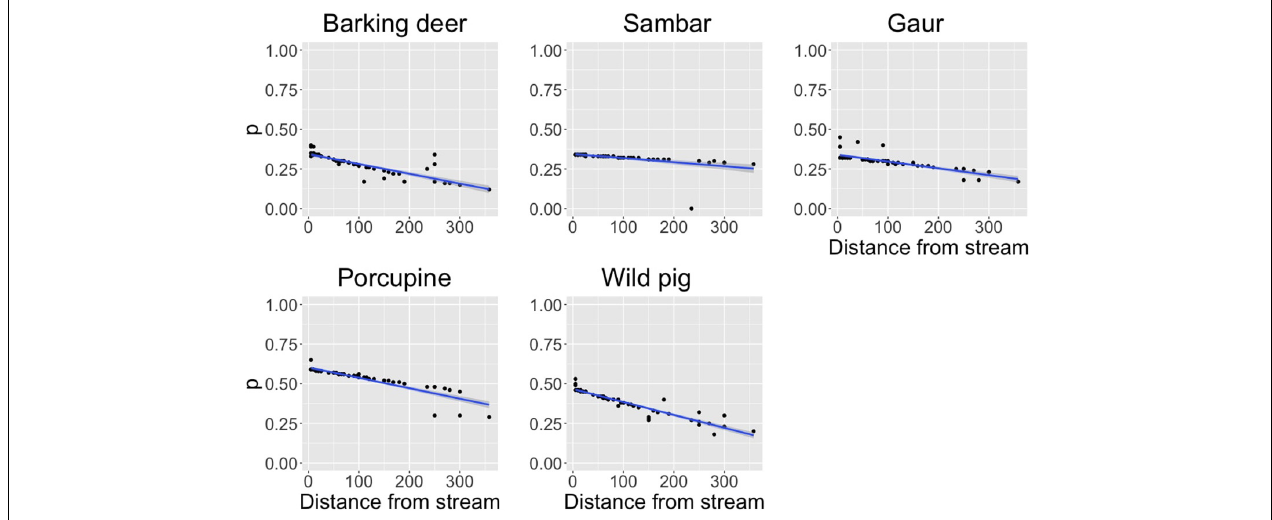
FIGURE 6 | Effect of distance from stream on species detection